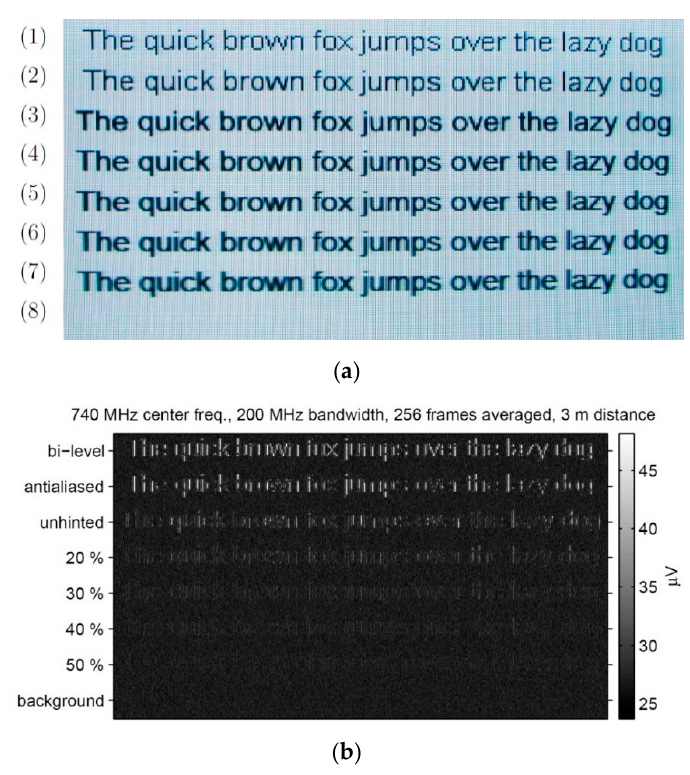
Figure 2. ( a ) A picture of the filtered fonts [14], ( b ) a picture for signal with limited spectrum [14].